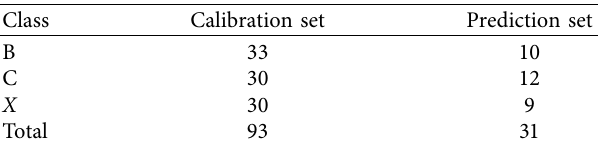
Table 1: Number of calibration and prediction samples in each